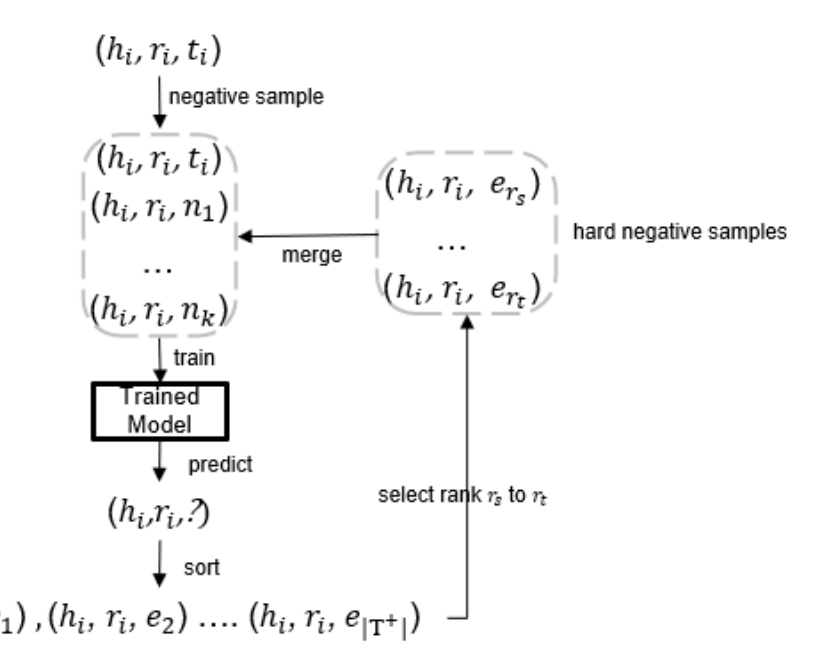
Figure 3. Process involved in mining hard negative samples. Table 3. Hyperparameter settings for mining hard negative samples on FB15k-237 and WN18RR. Parameter Value